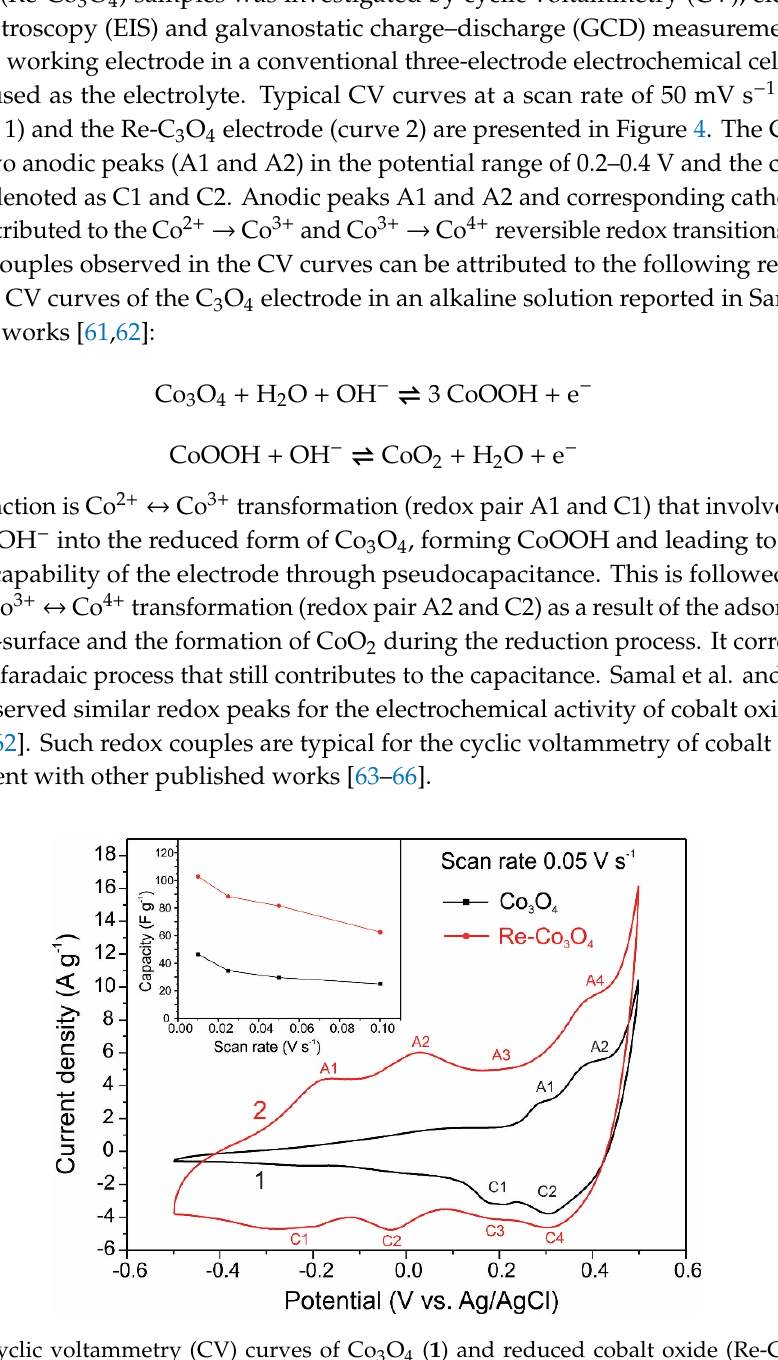
Figure 4. Cyclic voltammetry (CV) curves of Co 3 O 4 ( 1 ) and reduced cobalt oxide (Re-Co 3 O 4 ) ( 2 ) samples at a scan rate of 50 mV s −1 in a 3.5 M KOH aqueous solution. The inset shows the plot of capacity Cs versus potential scan rate for Co 3 O 4 ( 1 ) and Re-Co 3 O 4 ( 2 ) electrodes.